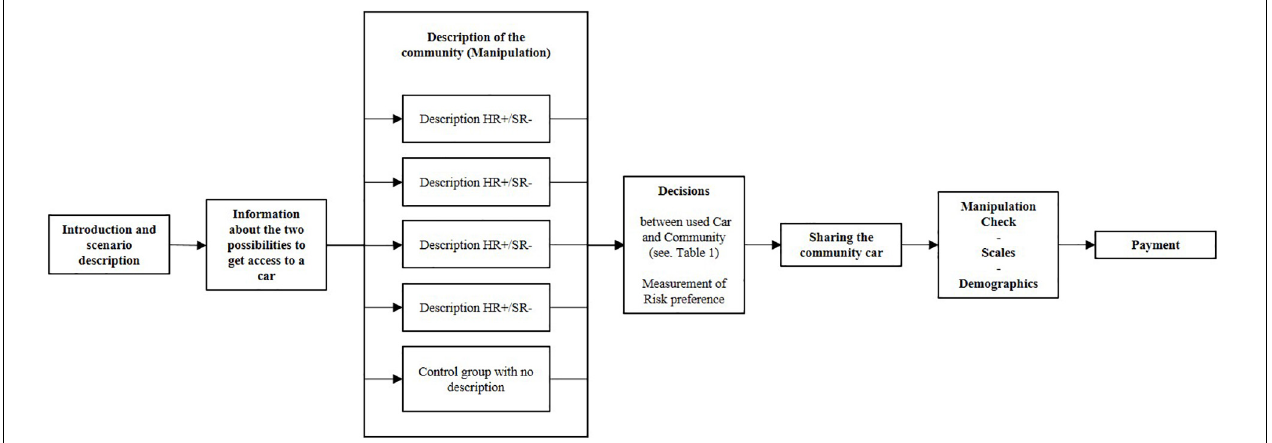
FIGURE 2 | Flowchart of procedure with manipulation of high/low harsh regulation (HR ± ) and high/low soft regulation (SR ± ).